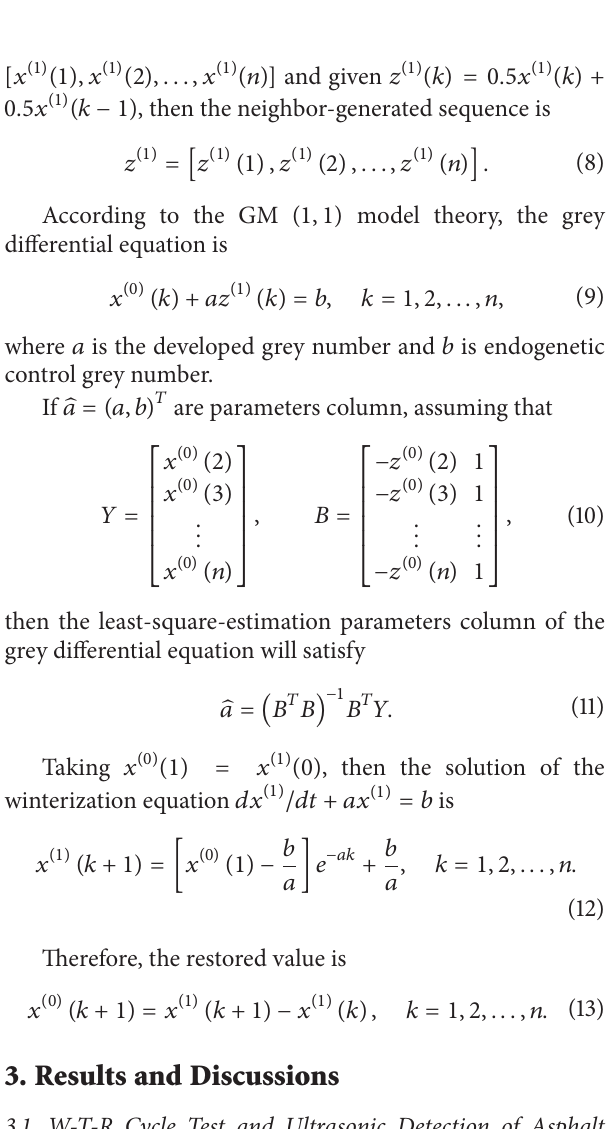
Figure 4: Ultrasonic testing method of asphalt mixture specimen.